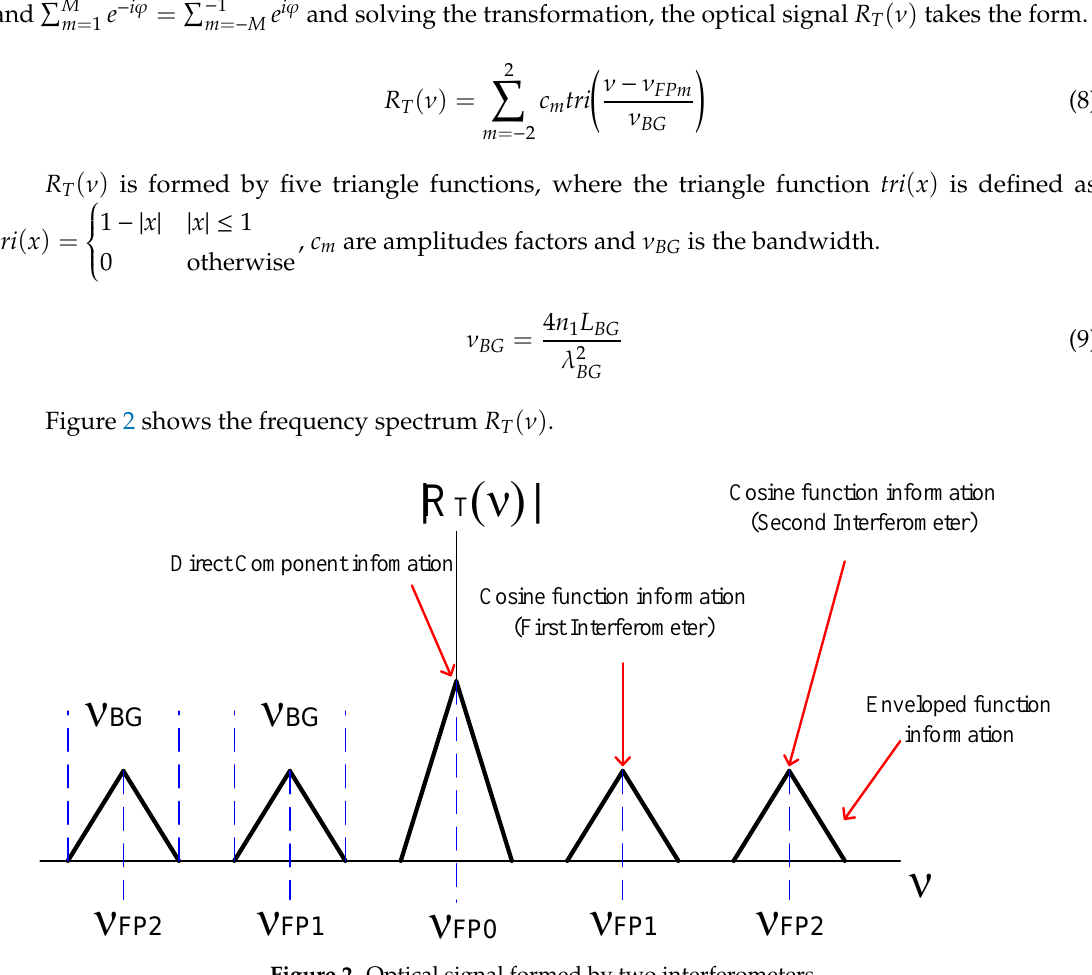
Figure 2. Optical signal formed by two interferometers.